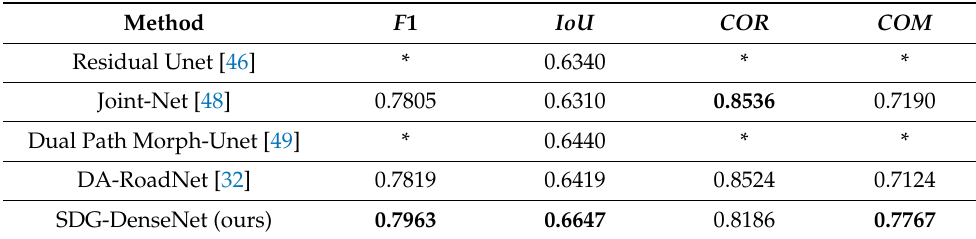
Table 4. Results of the Massachusetts Roads Dataset of different methods. The bold font indicates the optimal value under the current evaluation metrics.